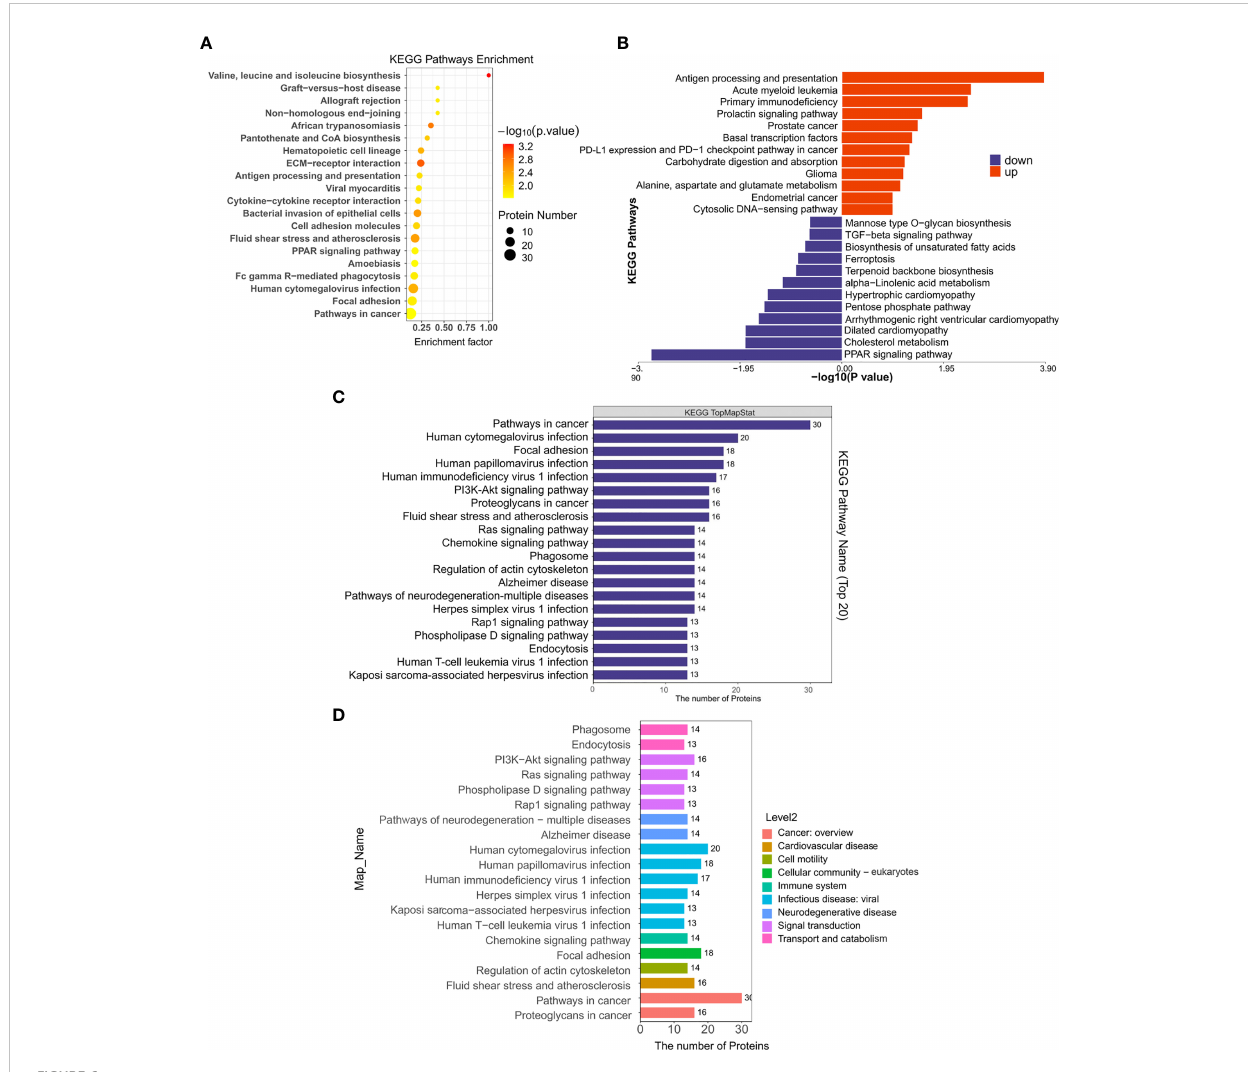
FIGURE 6 The KEGG pathway enrichment of DEPs. (A) KEGG pathway enrichment bubble chart. The horizontal axes represent the enrichment factor (enrichment factor ≤ 1). The vertical axis represents the statistical results of DEPs under the Top 20 KEGG pathways. The color gradient from green to red represents the p-value; the closer to the red color, the lower the p-value and the higher the signi fi cance level corresponding to the enrichment. (B) Signi fi cantly enriched pathways in up/down-regulated DEPs in the Sema/HFD group. (C) Numbers of DEPs under Top 20 KEGG pathways. (D) Numbers of DEPs under level 2 KEGG